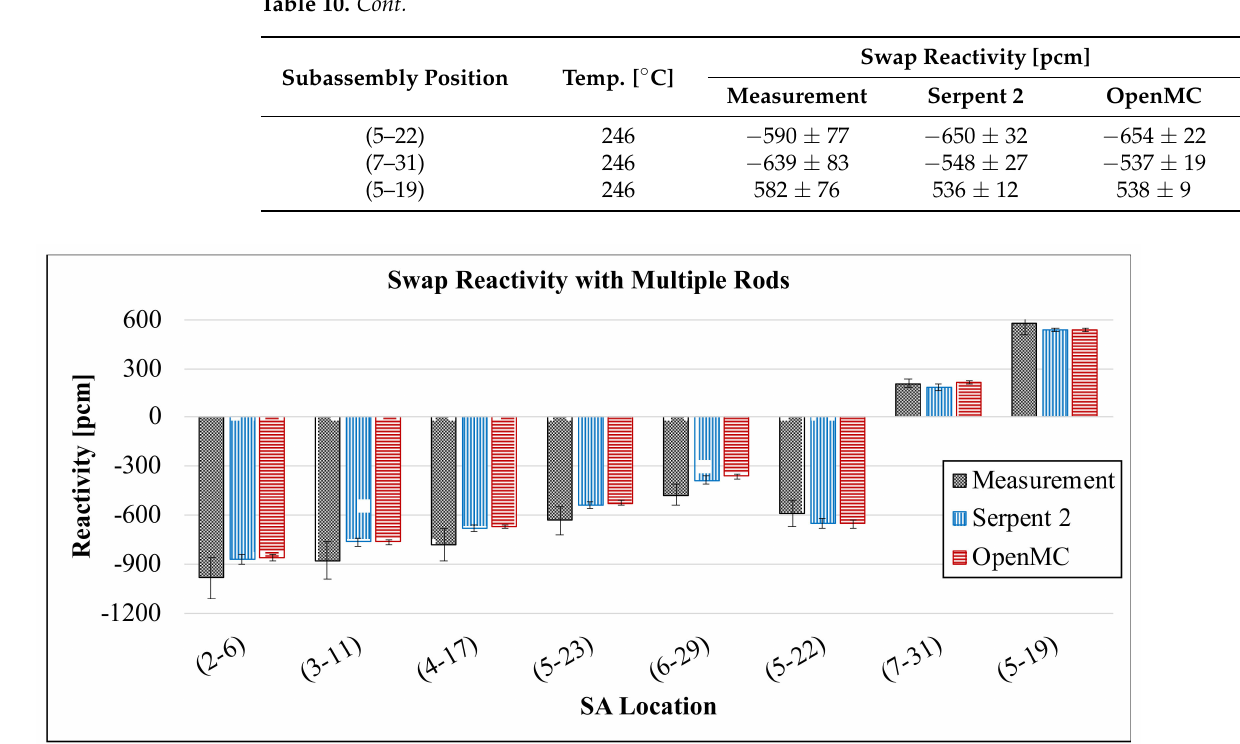
Figure 16. Comparison of swap reactivity results: test case of multiple rods.